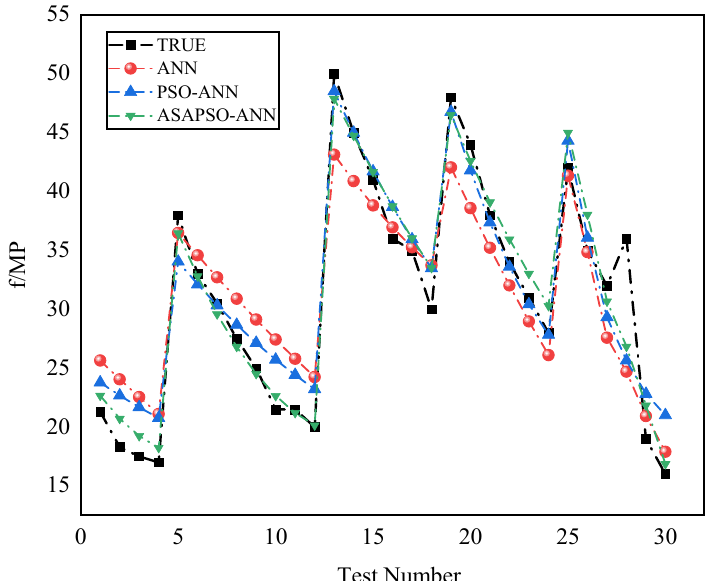
Figure 9. Comparison of data from three model testing sets.